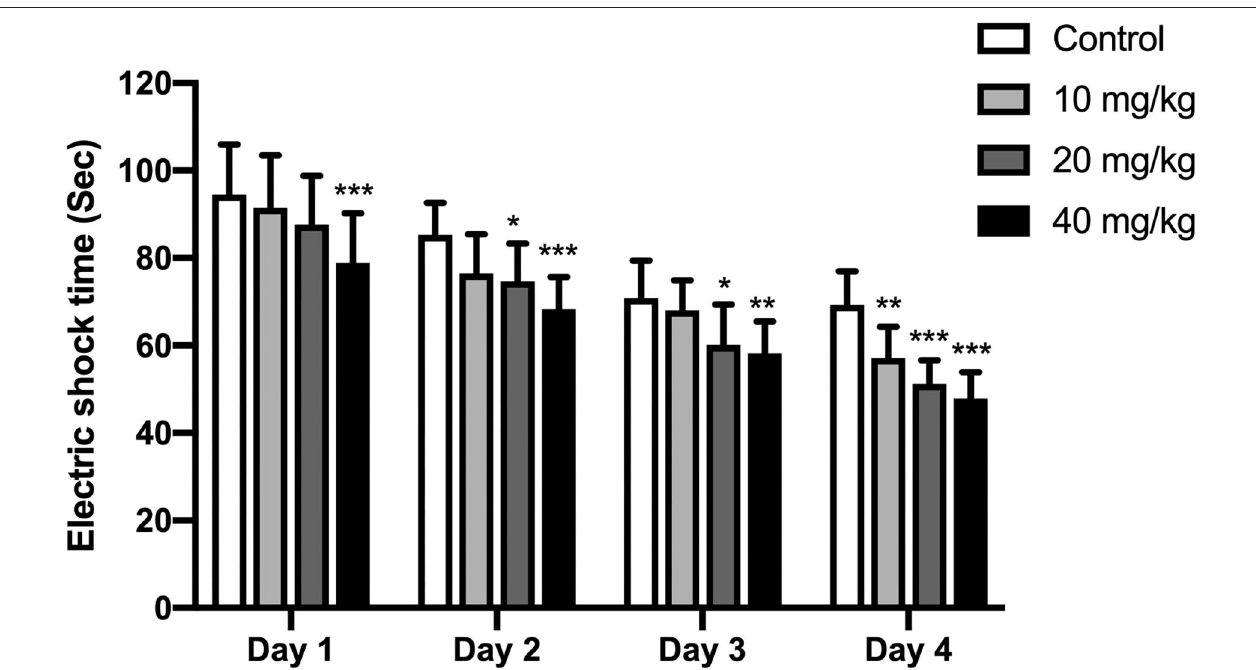
FIGURE 4 | Effects of perinatal Neu5Ac exposure on the electric shock time in the shuttle box test in 100-day-old male rat offspring. Mother rats were treated with Neu5Ac [10, 20, or 40 mg/(kg · day)] or water (as control) from gestational day 15 to postnatal day 21. The shuttle box test was used to evaluate passive avoidance learning in mice following the Morris water maze (MWM) test. The results are expressed as the M ± SD ; n = 10 per group. * P < 0.05, ** P < 0.01, *** P < 0.001 indicate a significant difference compared with control-group